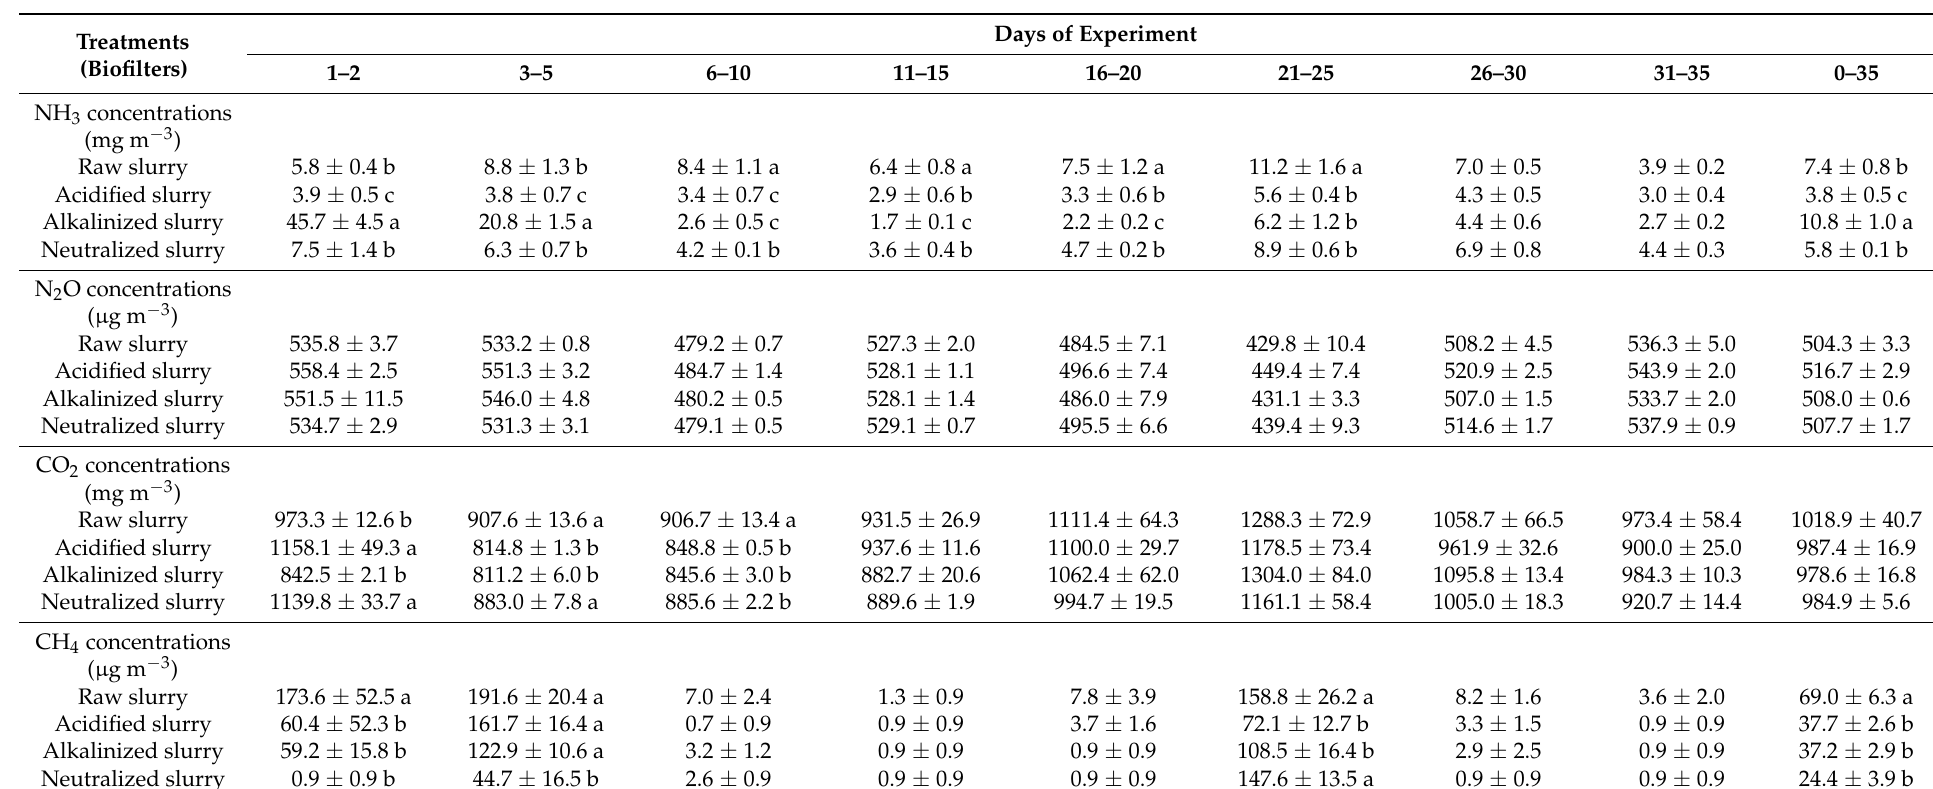
Table 4. Average gas concentrations in the biofilter outlet air of each treatment (mean ± standard deviation) ( n =